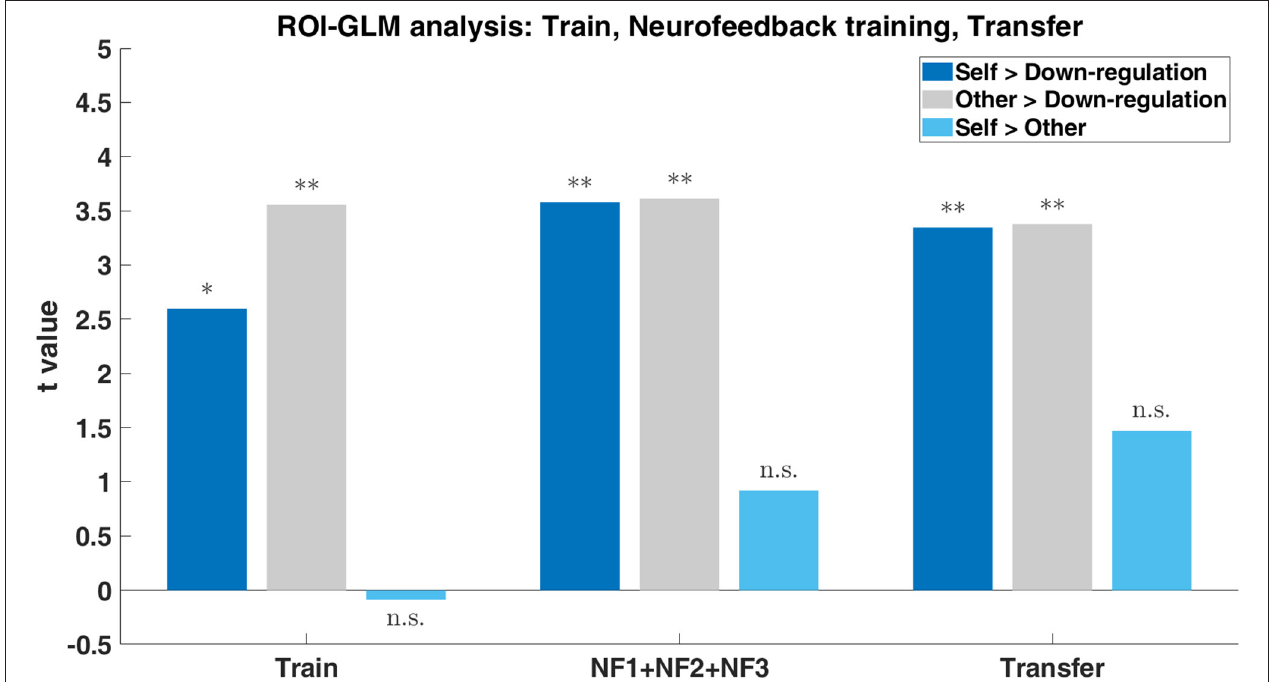
FIGURE 8 | Group results ( n = 17) to the three imagery tasks (“Self”: imagine itself in painful situations; “Other”: imagine a loved-one in painful situations; “Down-regulation”: imagine pleasure situations) within the ROI on the left-DLPFC during the train, neurofeedback training (NF1, NF2, and NF3) and transfer. Bar plot of the t -values for the contrasts Self > Down-regulation (dark blue), Other > Down-regulation (gray), and Self > Other (light blue) with p -values significance (*0.05,